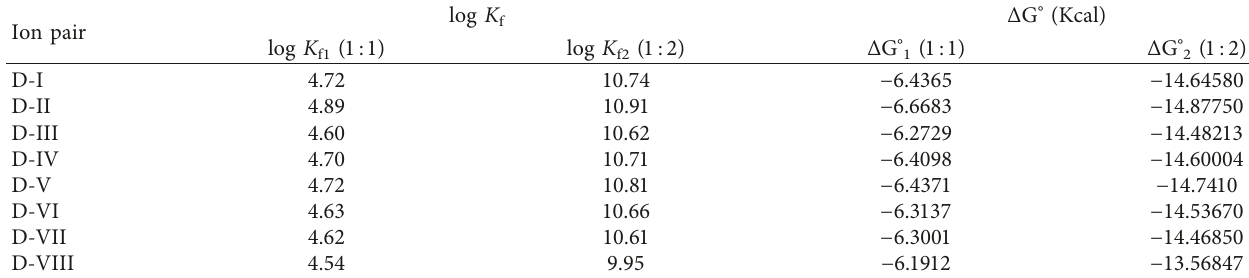
Table 3: Association constant and free energy ( Δ G ° ) obtained from the molar ratio and continuous variation method of ion-associate complexes under investigation.